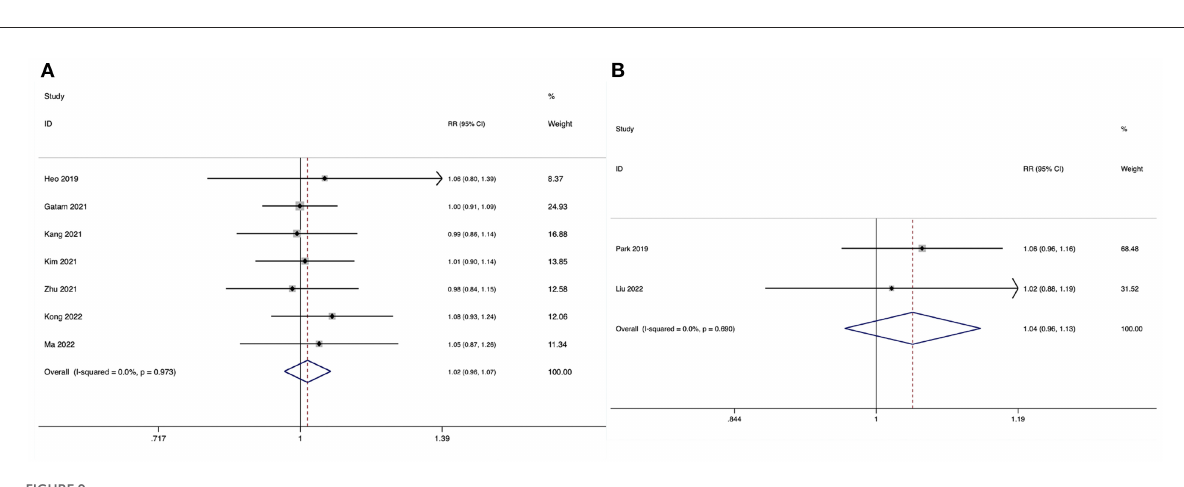
FIGURE9 Forest plot of the fusion rate. (A) ULIF vs. MI-TLIF; (B) ULIF vs.